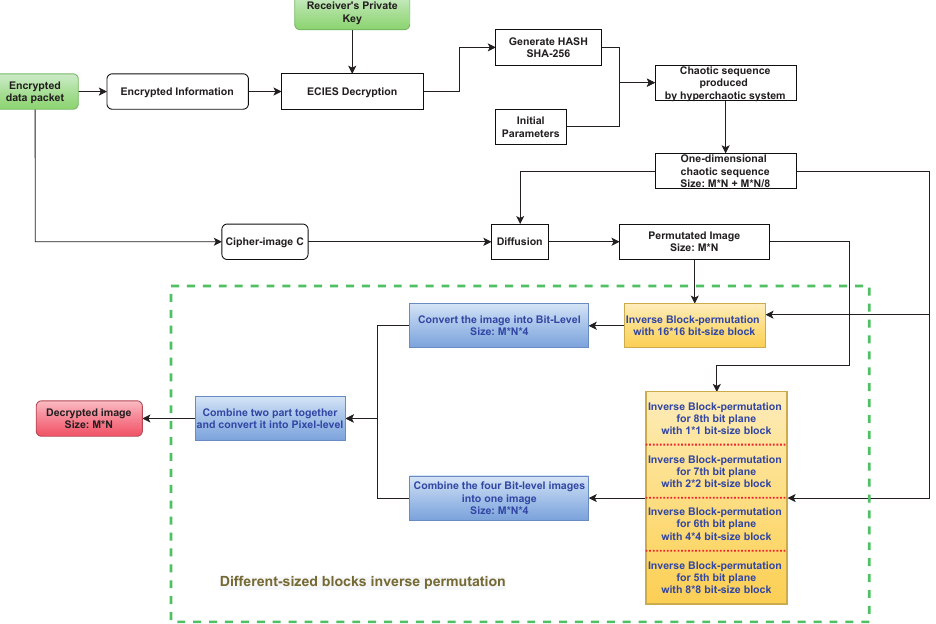
Figure 9. The concrete flow chart for the decryption